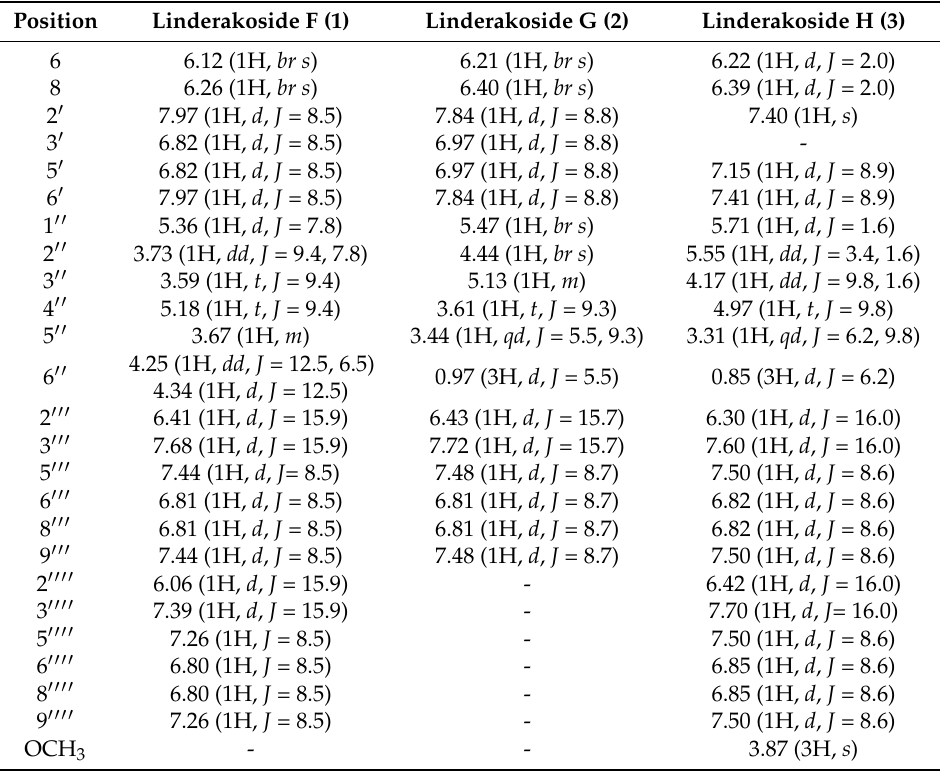
Table 1. 1 H-NMR spectroscopic data of compounds 1 – 3 (in methanol- d 4 , 500 MHz) a